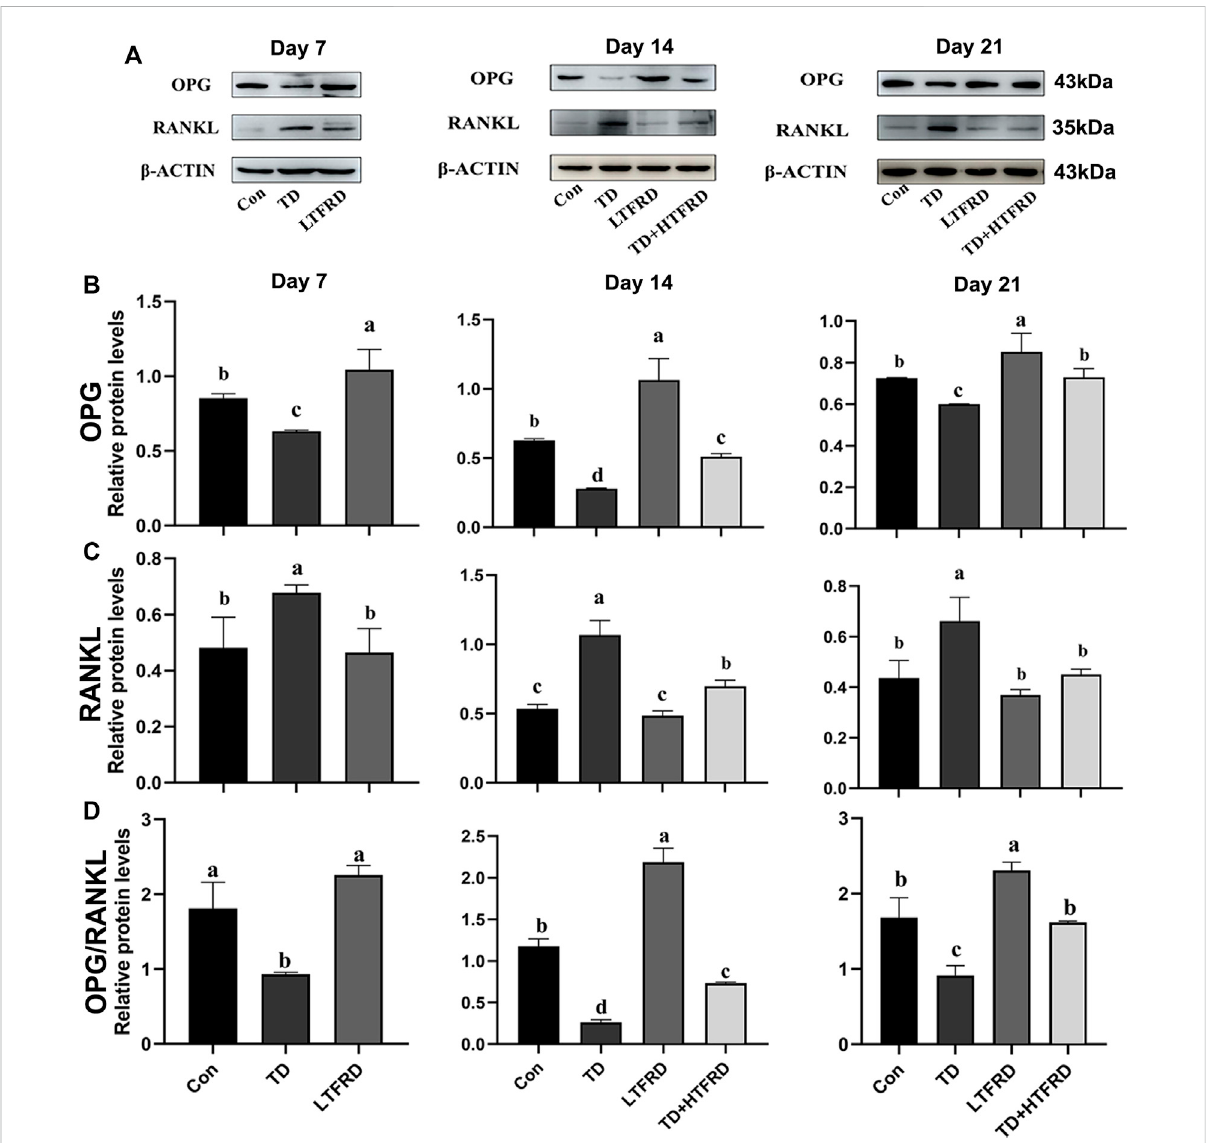
FIGURE 5 Effects of LTFRD on OPG/RANKL protein level of tibial growth plate in TD broilers. (A) The gray scale analysis of OPG, RANKL, and β -ACTIN. (B) TheproteinlevelofOPG. (C) TheproteinlevelofRANKL. (D) TheproteinlevelofOPG/RANKLTheresultsarerepresentedasmean±SD.a,b,c,andd represent signi fi cant differences between groups ( p <